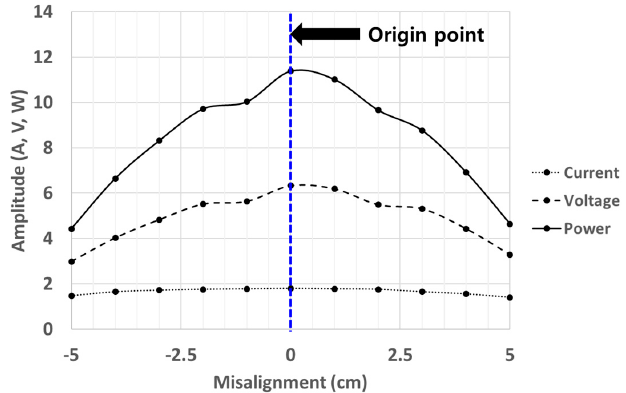
Figure 24. Voltage and current measured at the load, and its calculated power (second experiment: experimental vehicle load).